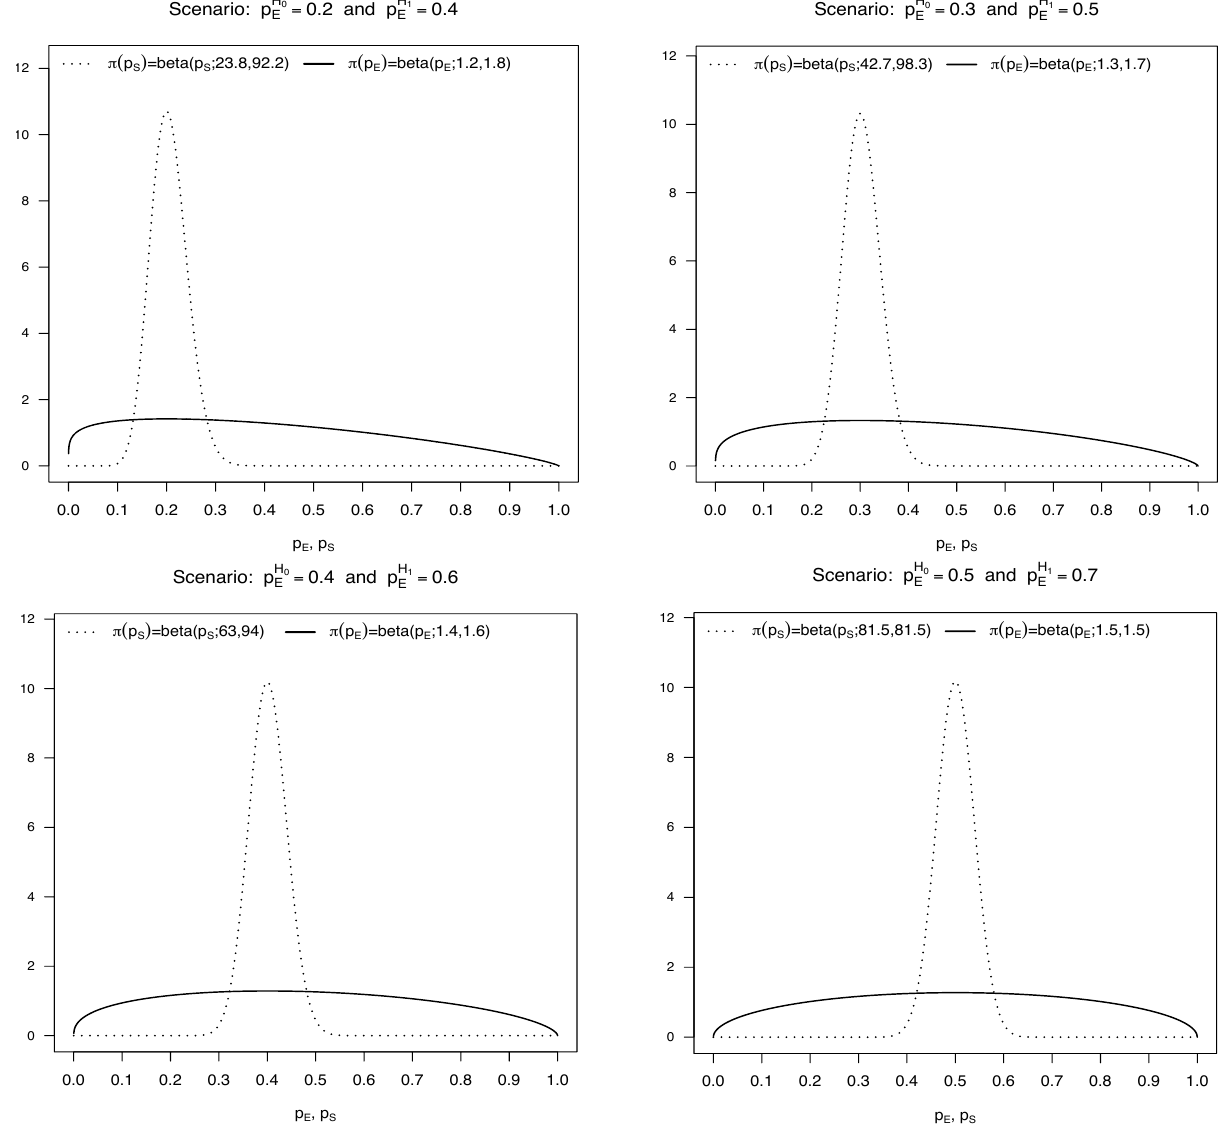
Figure 5. Beta prior distributions of p E and p S for each of the scenarios used in the simulation